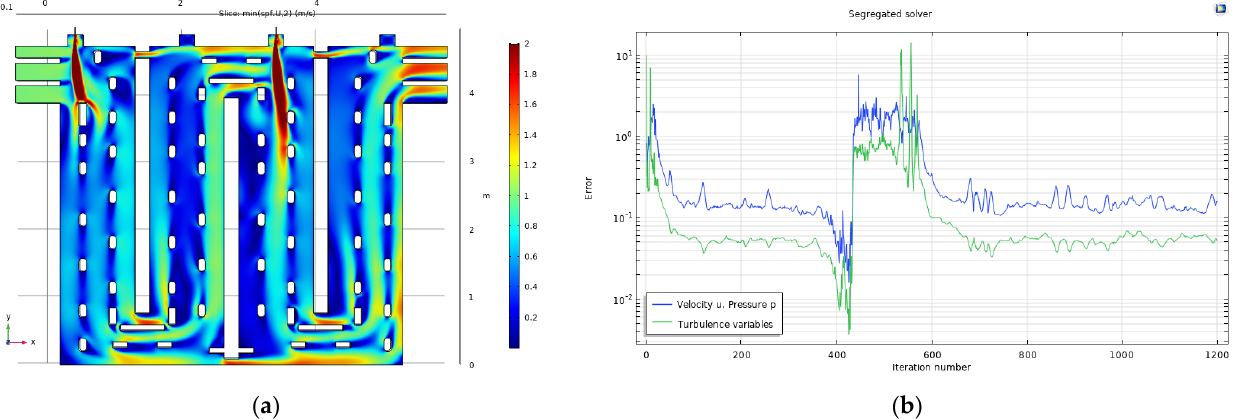
Figure 12. Model 9: No artificial diffusion using mesh 2. Initial value for Newton Raphson method: results of model 8. ( a ) Velocity field (dimensions m/s) at iteration 400; ( b ) Segregated solver plot.